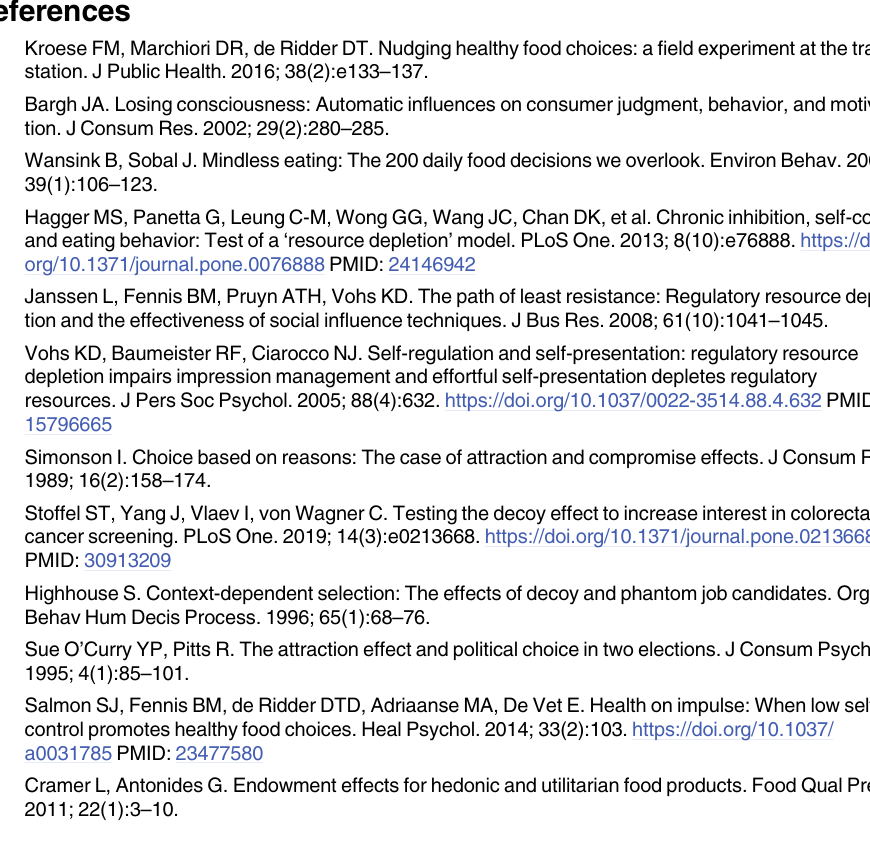
S1 Table. Choice sets with mean perceived level of attractiveness and healthiness. S2 Table. Choice sets main